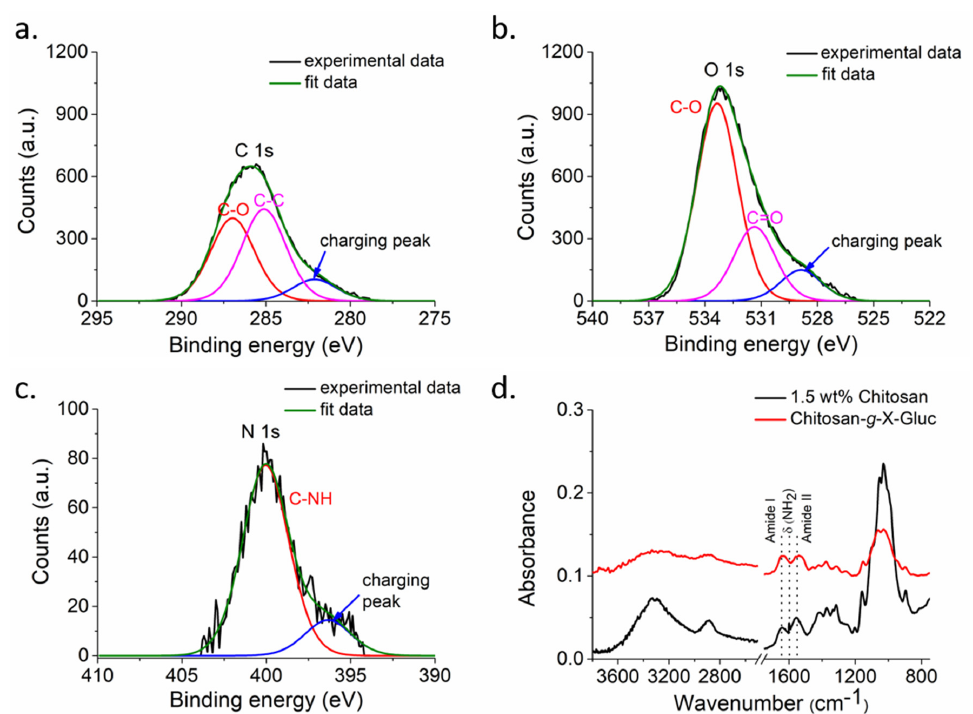
Figure 2. X-ray photoelectron spectroscopy (XPS) high-resolution spectrum of 1.5 wt% chitosan deposited on paper sub- strate for ( a ) C1s, ( b ) O1s and ( c ) N1s. ( d ) attenuated total internal reflection (ATR)-Fourier transform infrared (FTIR) spectra of paper modified with chitosan (sample coated twice using 1.5 wt% chitosan solution in 1% acetic acid, black trace) and chitosan functionalized with the chromogenic substrate X-Gluc (sample coated twice using 1.5 wt% chitosan solution in 1% acetic acid, red trace).